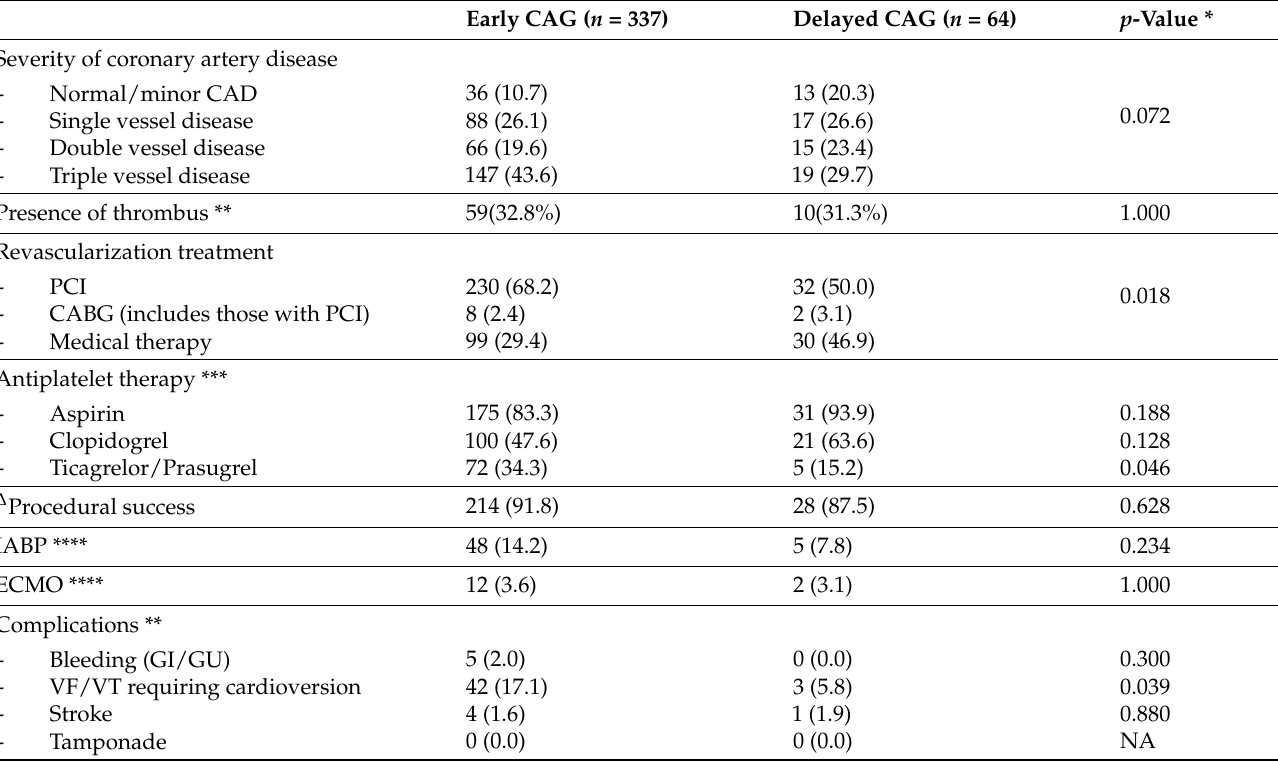
Table 2. Characteristics of coronary artery disease, treatment, and